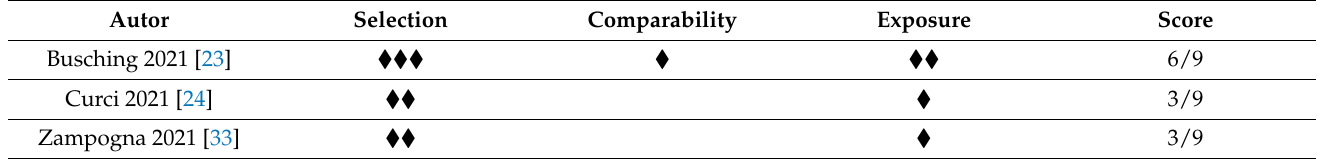
Table 4. NOS for retrospective observational